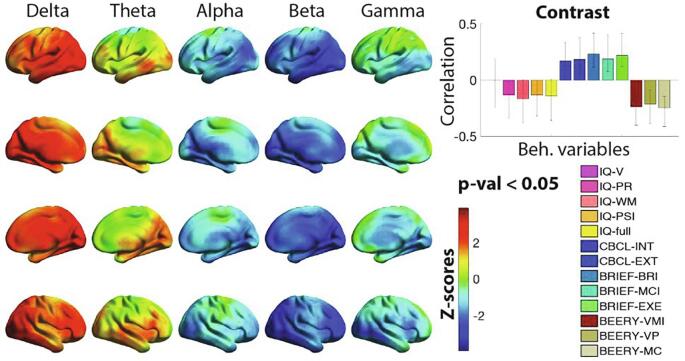
Correlation between power and neurocognitive measures. Plotted on the cortical surfaces are z-scores indicating the reliability of expressing the correlation between the set of neurocognitive variables (explained in Methods section) and power. The bar graph contrast plotted on the top right indicates the correlation values for each of the variables and the whiskers indicate the 95% confidence interval. Confidence intervals not crossing the 0 line are considered significant. The contrast indicates negative > positive outcomes, thus higher power in red z-scores indicates higher negative outcomes and lower positive outcomes, i.e. lower or higher IQ, difficulties in executive functions and visual motor integration, conversely, lower powers represented in blue indicate lower negative and higher positive outcomes. Statistical analysis was performed on an 8 mm spaced grid, for visualization purposes, the z-scores were interpolated onto cortical surfaces. N = 98. (For interpretation of the references to colour in this figure legend, the reader is referred to the web version of this article.)